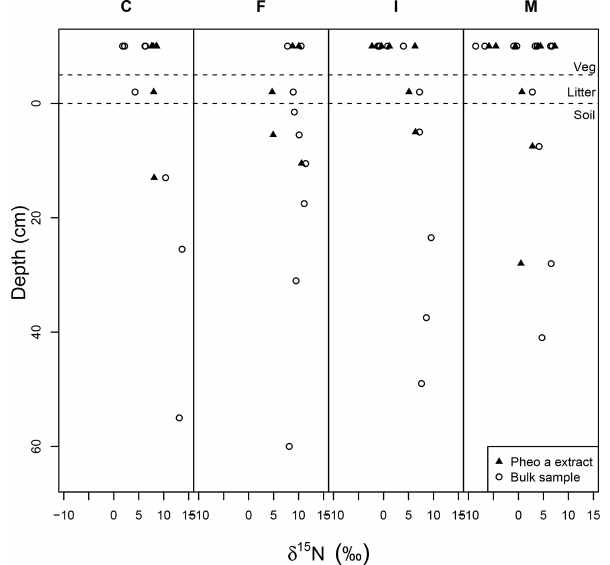
Figure 6. Bulk samples (open circles) and pheo a -specific (closed triangles) δ 15 N in depth profiles across the rainfall gradient from dry (C) to wet (M) sites. Dashed lines set apart the vegetation sam- ples (top) from litter samples (middle) and soil samples (bottom). The surface of the mineral soil is at a depth of